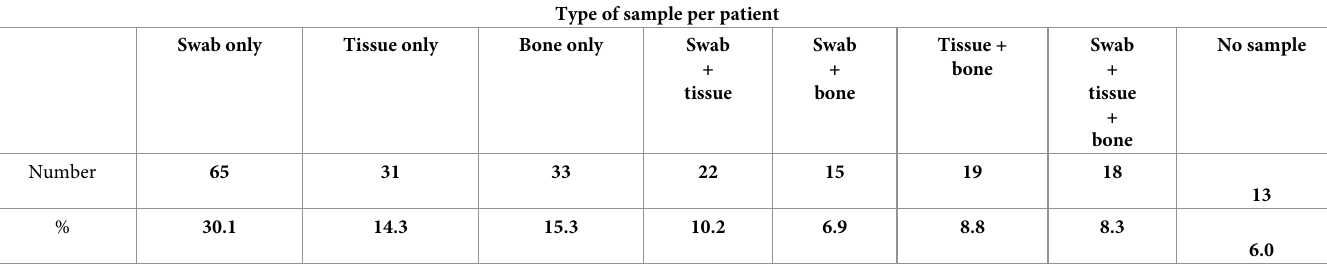
Table 2. Type of microbiology sample per patient for diagnosis of diabetic foot